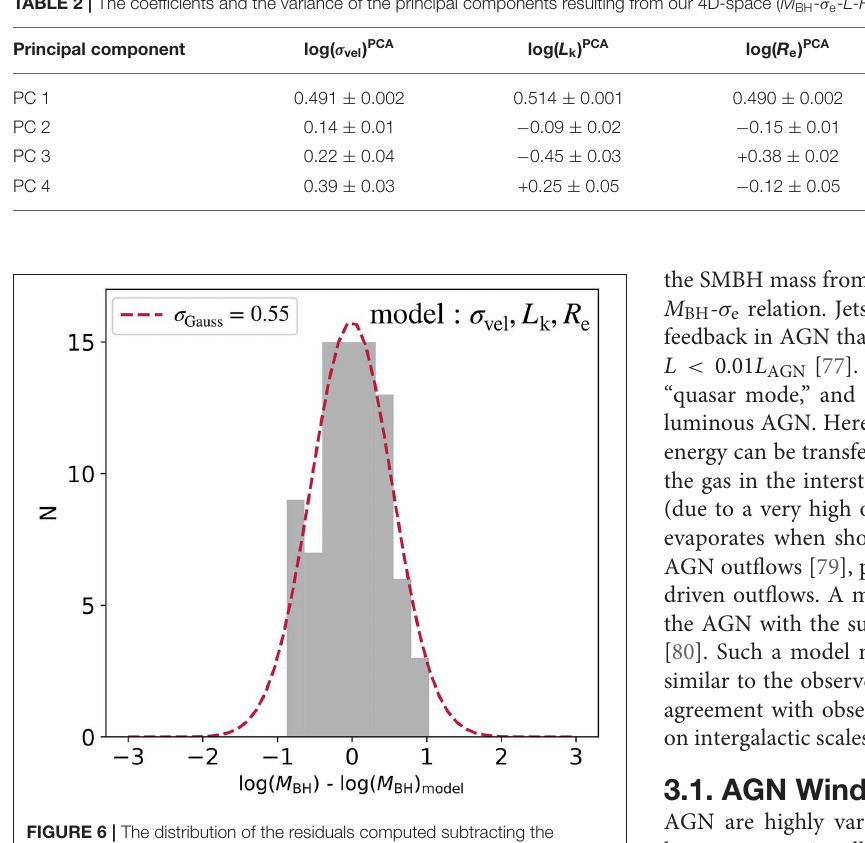
FIGURE 6 | The distribution of the residuals computed subtracting the 4D-space PCA model predictions to the observed M BH is shown (gray histogram), along with its Gaussian fits (red dashed